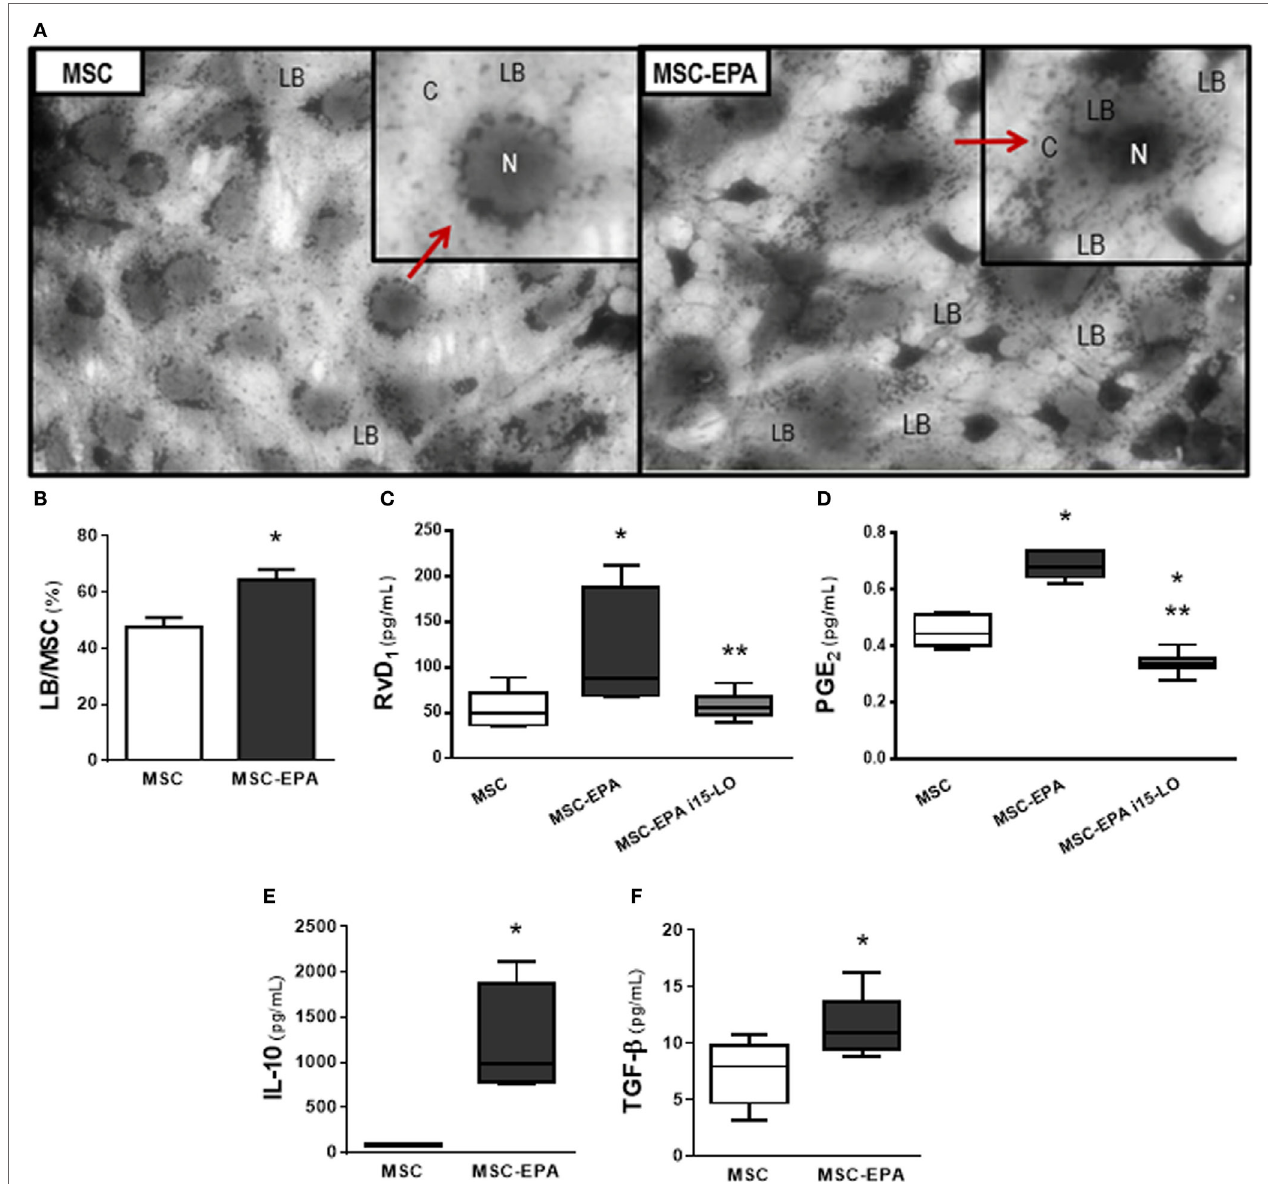
FigUre 1 | EPA-stimulated lipid body formation in MSCs and modulated secretion of biomarkers by MSCs. (a) LB (red arrow) in MSCs and EPA-MSCs stained with